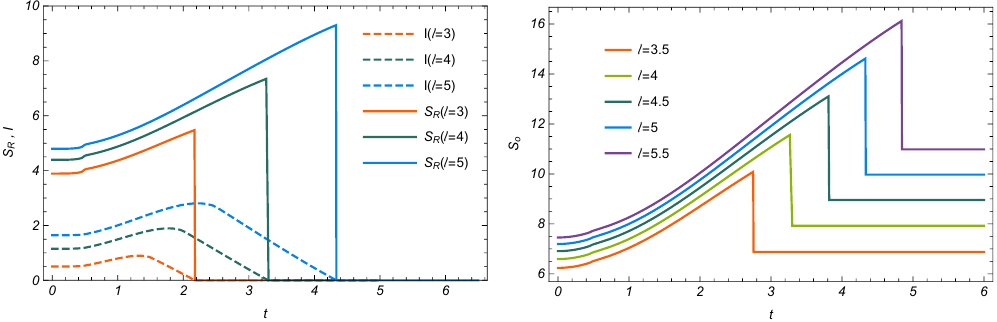
Figure 17 . Evolution of re(cid:13)ected entropy and mutual information (left) and odd entropy (right) in d = 2. Here we have set h = 1.